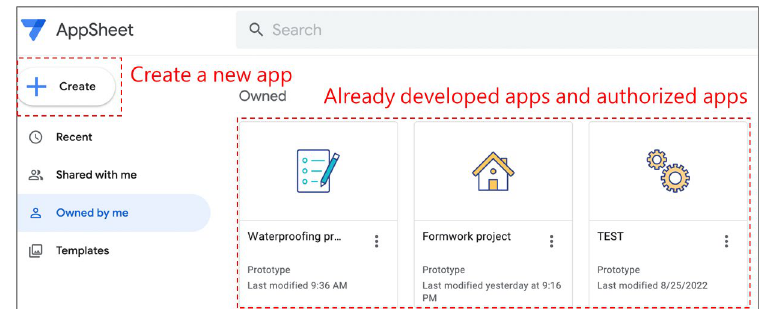
Figure 14. Screen image after sign-in